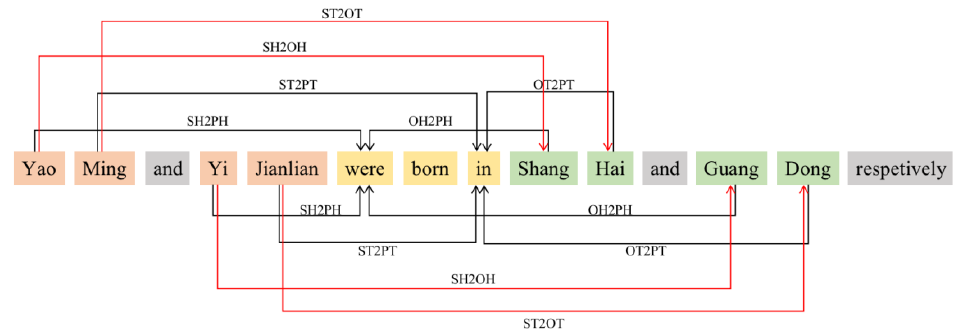
Figure 3. Three-times-handshaking decoding example in extreme cases.